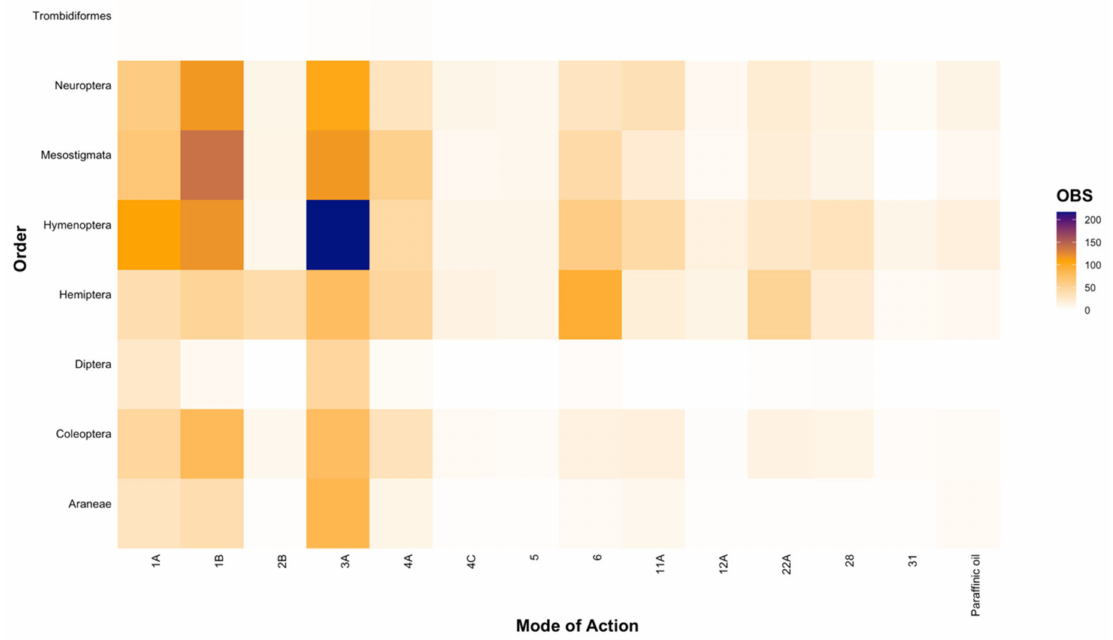
Figure 4. The number of entries (OBS) that tested the toxicity of chemical Modes of Action for each natural enemy order relevant to the Australian grains